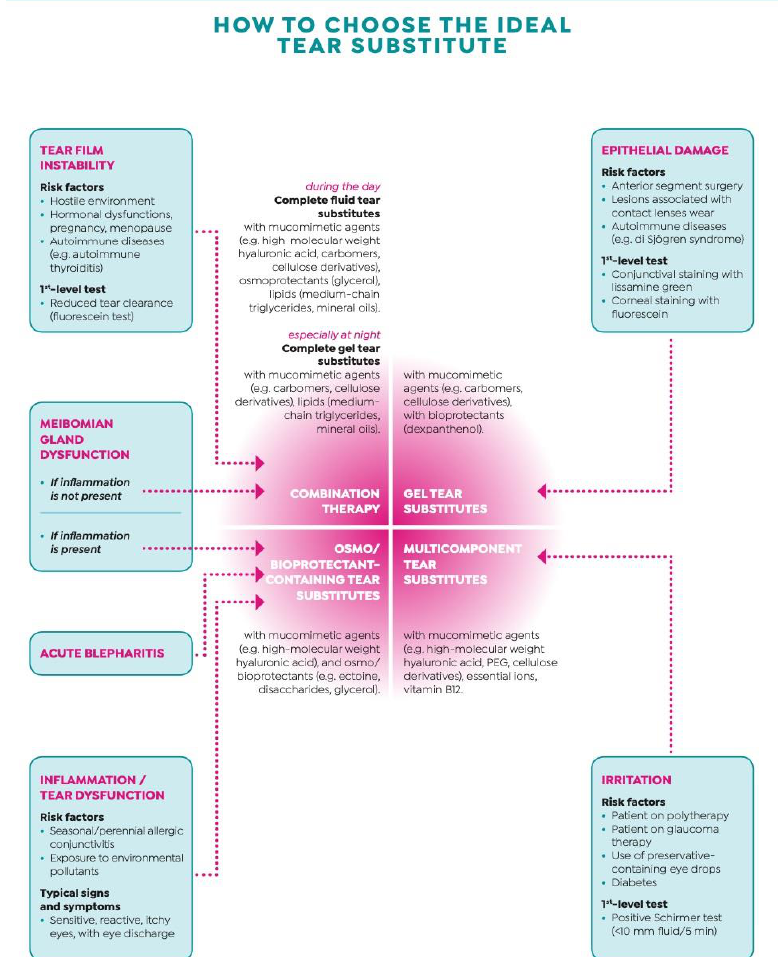
Figure 2. The choice of the ideal tear substitute according to patients’ clinical picture. Modified from “Malattia dell’Occhio Secco—Dalla definizione alle strategie terapeutiche” with the permission of Editamed srl.